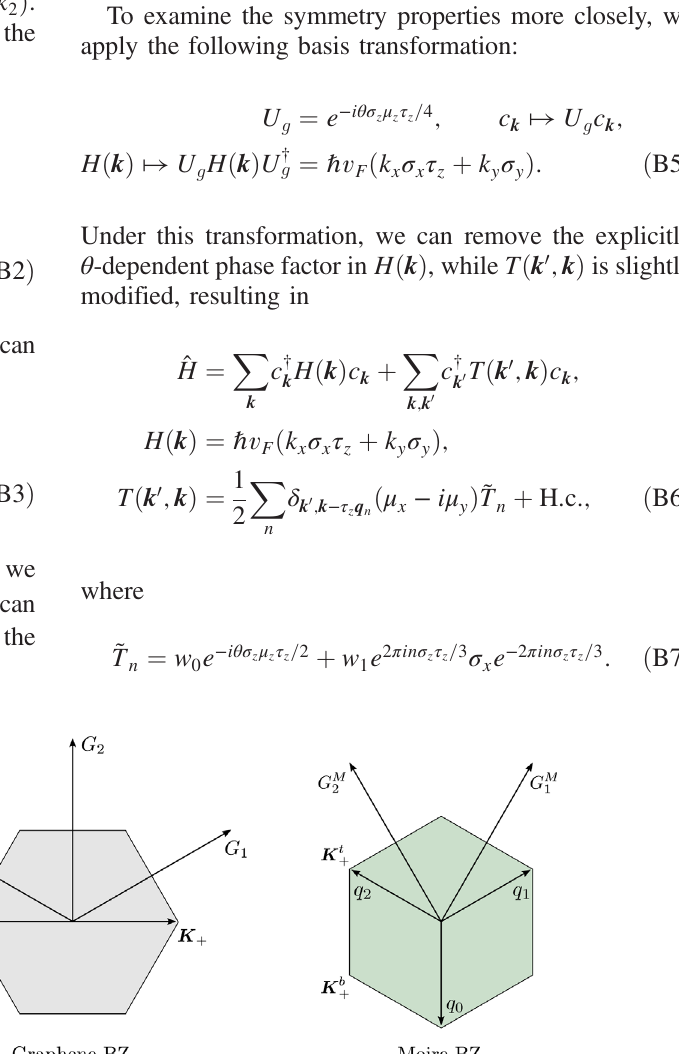
FIG. 5. Real-space lattice and Brillouin zone for a single graphene layer, and Brillouin zone originating from the K twisted bilayer graphene. The figure illustrates all vectors discussed in the